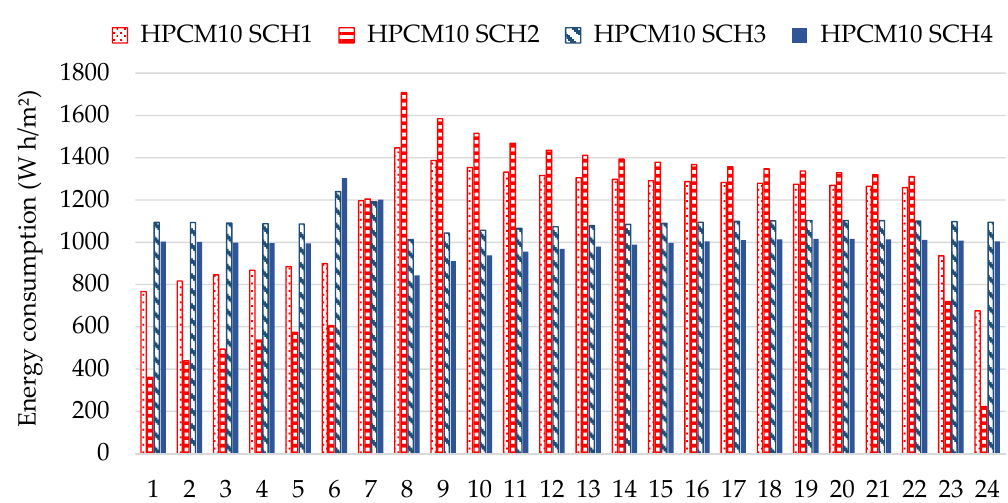
Figure 14. Average hourly heating energy consumption of HPCM10 wall under four schedules. Figure 15 provides additional insights into the performance of the HPCM10 wall type through the investigation of the phase change hours in the three layers—internal, mid, and external—under all five investigated control strategies. As presented, the phase change hours of the inner layer increased as the control strategies changed from the BC schedule to SCH4, and the opposite applied to the middle and exterior layers of the HPCM10 wall assembly. Hence, the interior layer exhibited 24% (SCH2 and 3) to 27% (SCH4) more phase change hours than the BC controls. The middle section performed the best under BC, SCH1, and SCH2 with approximately 6000 phase change hours, and the worst under SCH4 and SCH3 with 9% and 29% fewer hours, respectively. The external layer performed the best under the BC scenario owing to its distance from heating controls, followed by SCH3 and SCH2 with approximately 17% and SCH4 with 25% fewer phase change hours. Considering that the layers closer to the indoor space have the most considerable impact on the interior temperatures and thermal comfort, these results suggest that the HPCM10 wall performed better under SCH2, SCH3, and SCH4 controls compared to the BC and SCH1 strategies.